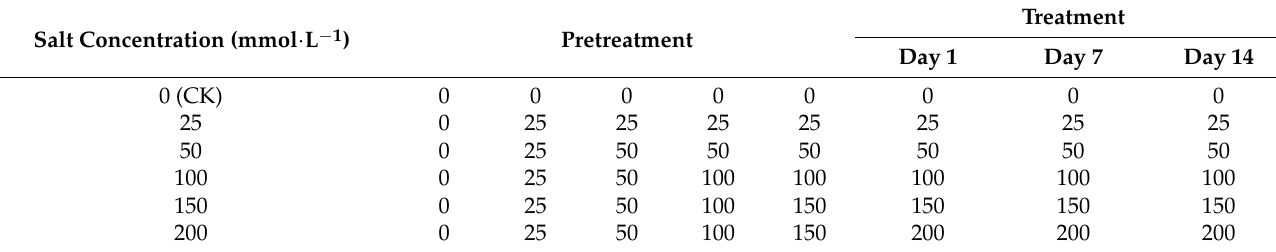
Table 2. Details of the NaCl and NaHCO 3 treatment